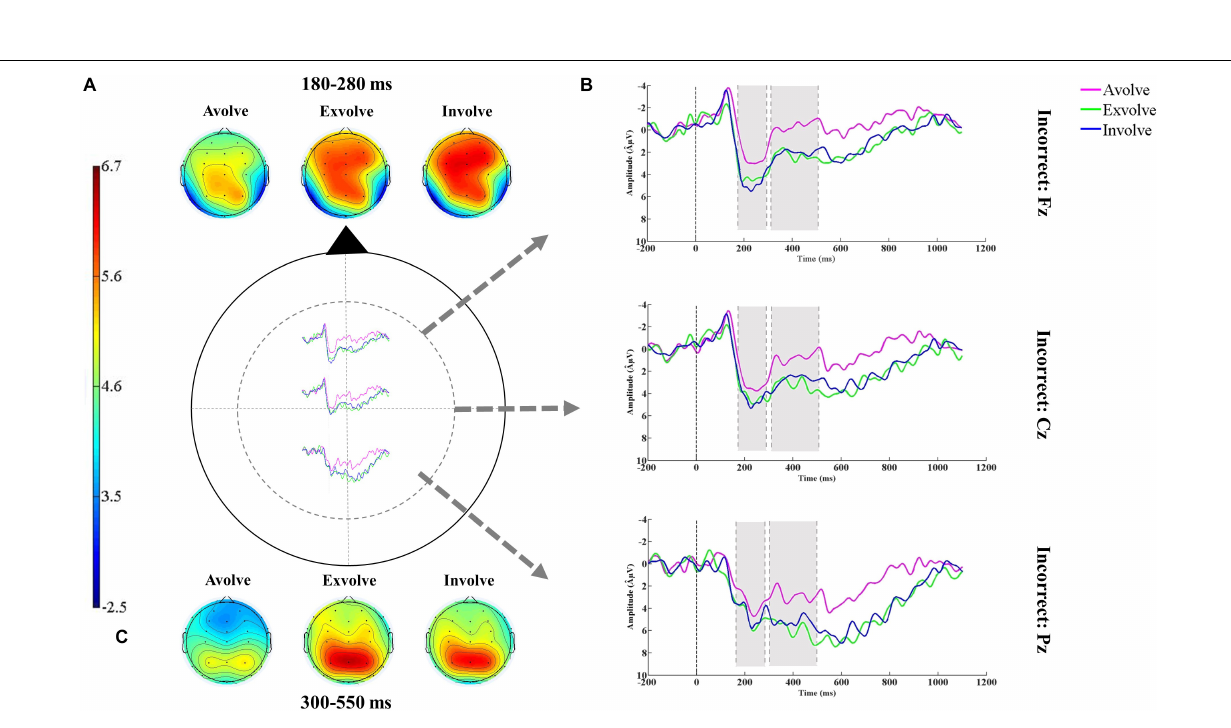
FIGURE 5 | (A) The topographic maps plotted in the latency window of 180–280 ms after the stimulus onset. (B) Grand-average ERPs ( N = 18) elicited by the pragmatically incorrect condition in response to different combinations of senses (i.e., avolvement, exvolvement, and involvement). (C) The topographic maps plotted in the latency window of 300–550 ms after the stimulus